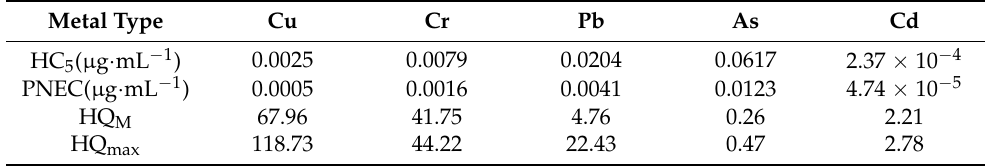
Table 2. Evaluation of the HQs of the metals.